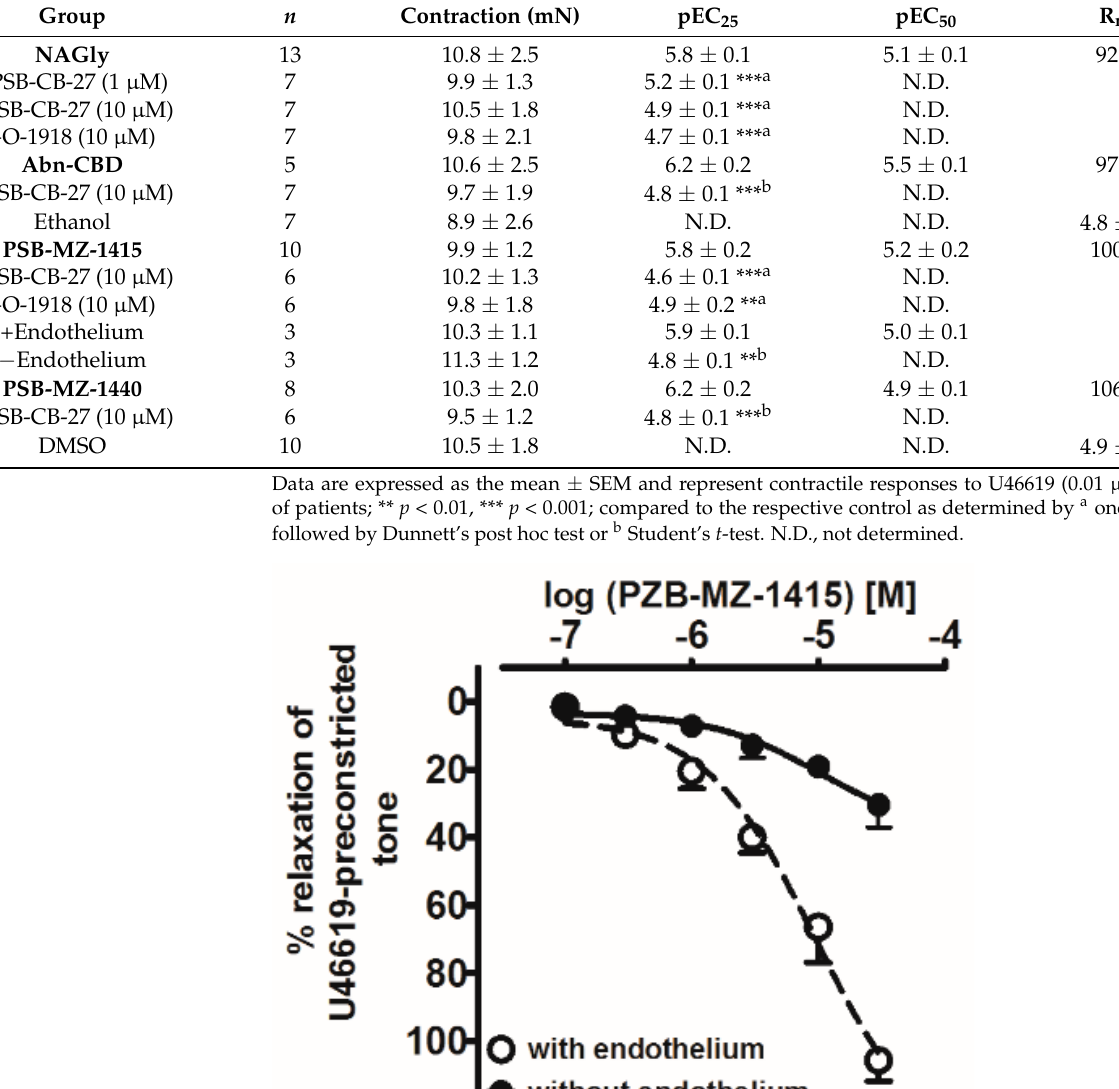
duced both its potency and its maximum effect (Figures 1 and 2A,C, Table 1). PSB-MZ-1440, NAGly and Abn-CBD also fully relaxed endothelial-dependent and U46619-precontracted hPAs (Figures 2B and 3A,B; for original traces see Figures 2D and 3C,D). The rank order of potencies (according to their pEC 50 values) was Abn-CBD ≥ PSB-MZ-1415 ≥ NAGly ≥ PSB-MZ-1440 (for pEC 50 , pEC 25 , and R max , see Table 1). Repeated administration of the vehicles DMSO and ethanol had a very slight vasorelaxant effect only (Figures 2 and 3, Table 1). Table 1. Vasodilatory effects of NAGly, Abn-CBD, PSB-MZ-1415, and PSB-MZ-1440 on U46619 (0.01 µ M)-precontracted isolated human pulmonary arteries (pEC 25 , pEC 50 ), interaction with PSB- CB-27 and O-1918, and effect of endothelial removal.